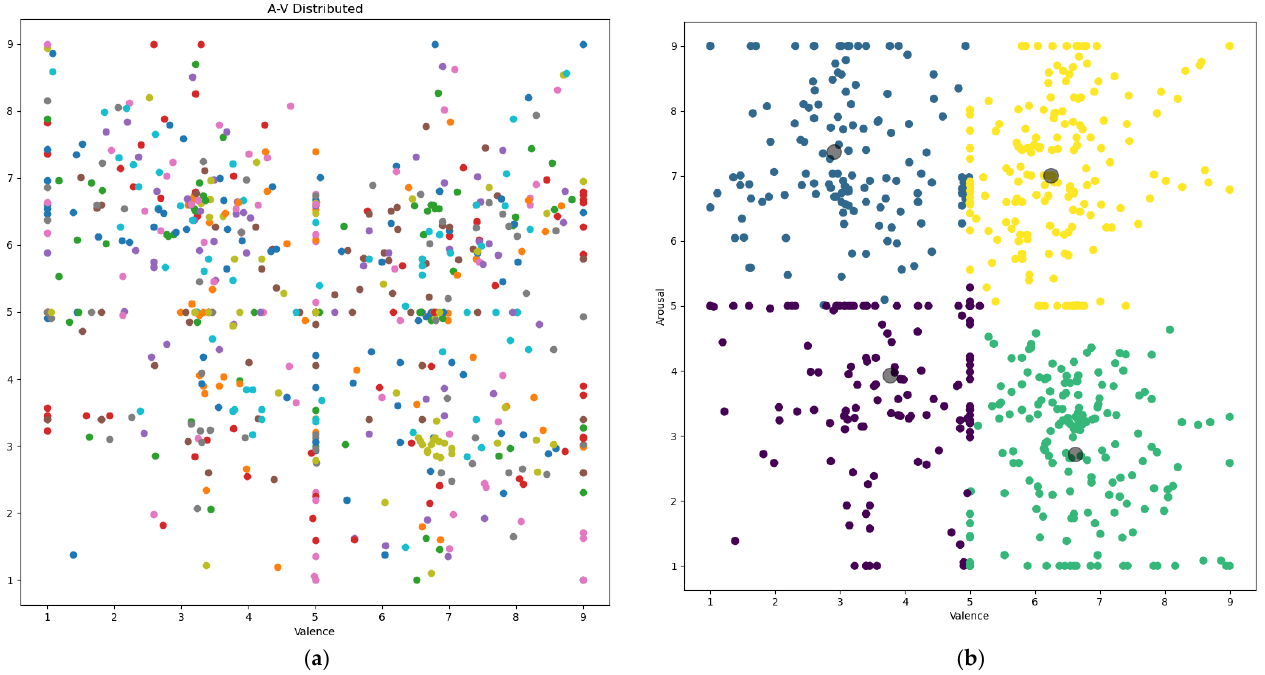
Figure 1. ( a ) Distribution of Arousal/Valence tags in AMIGOS dataset ( b ) Distribution of sentiment labels after processing with kmeans.